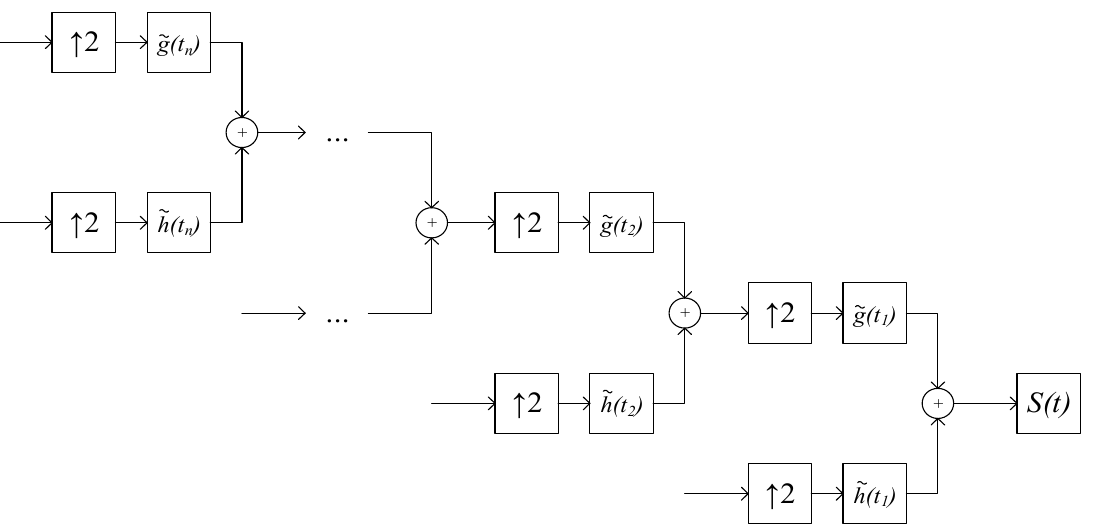
Figure 4. Reverse DWT ECG signal, where 𝑆(𝑡) is a noise-free ECG signal, 2 ↑ is interpolation, 𝑔(cid:3556) is a low-pass synthesis filter, ℎ(cid:3560) is a high-pass synthesis filter.